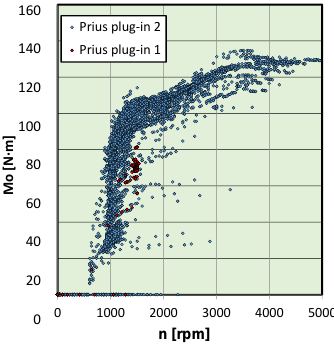
Fig. 11. Operational conditions of the combustion engines of tested hybrid vehicles in urban traffic conditions